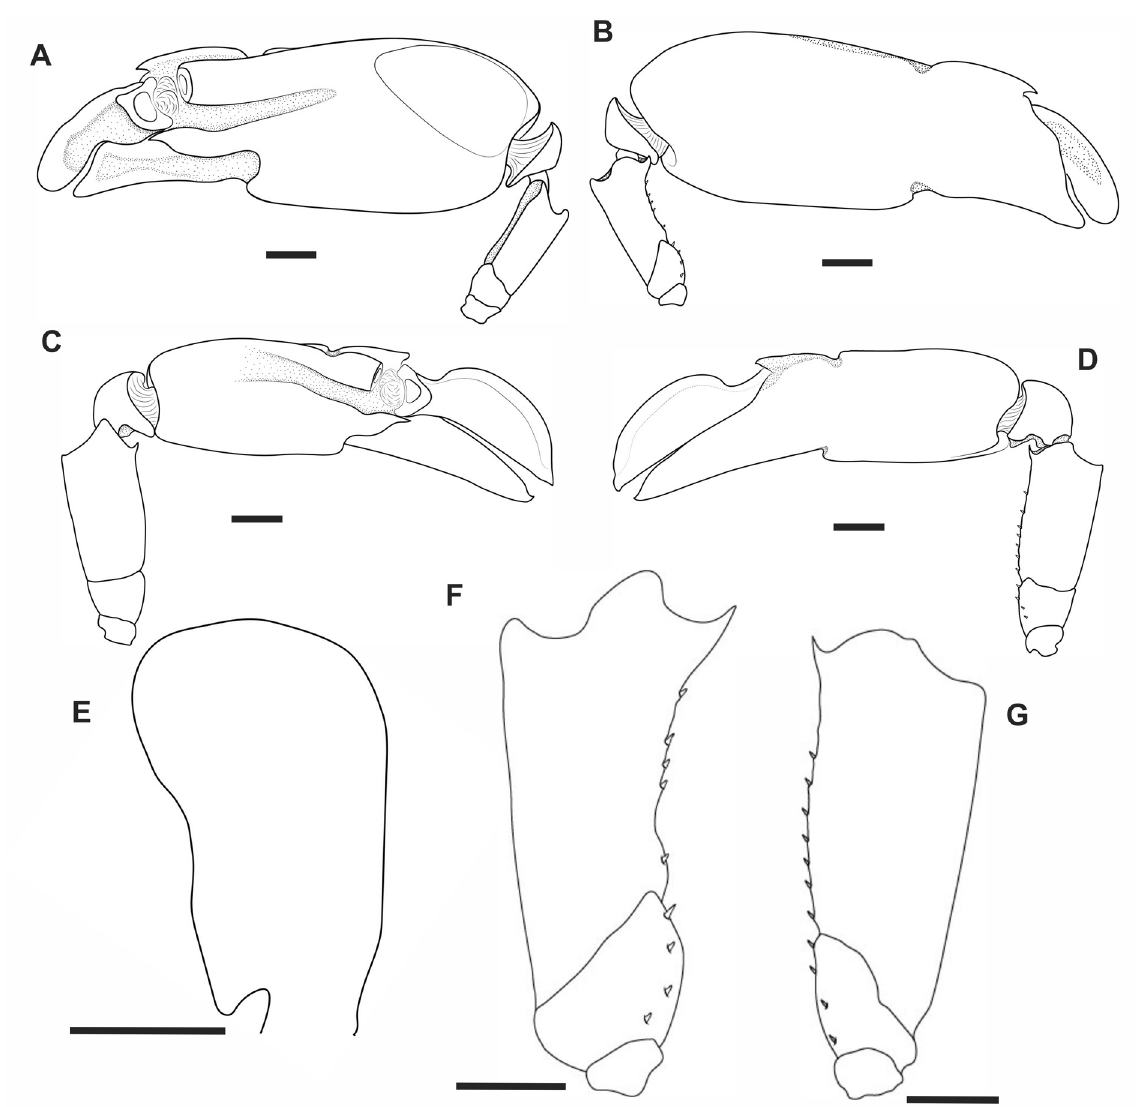
Fig. 2. Alpheus ramosportoae sp. nov., paratype, ♂, from seamounts of the North Chain, Ceará, northeastern Brazil (MOUFPE 13703). A . Major cheliped, lateral view. B . Same, mesial view. C . Minor cheliped, lateral view. D . Same, mesial view. E . Major chela dactylus, mesial view, detail of plunger. F–G . Detail of spiniform setae on ischium and propodus of major and minor chelae, respectively. Scale bars: A–E = 1 mm; F–G = 0.5